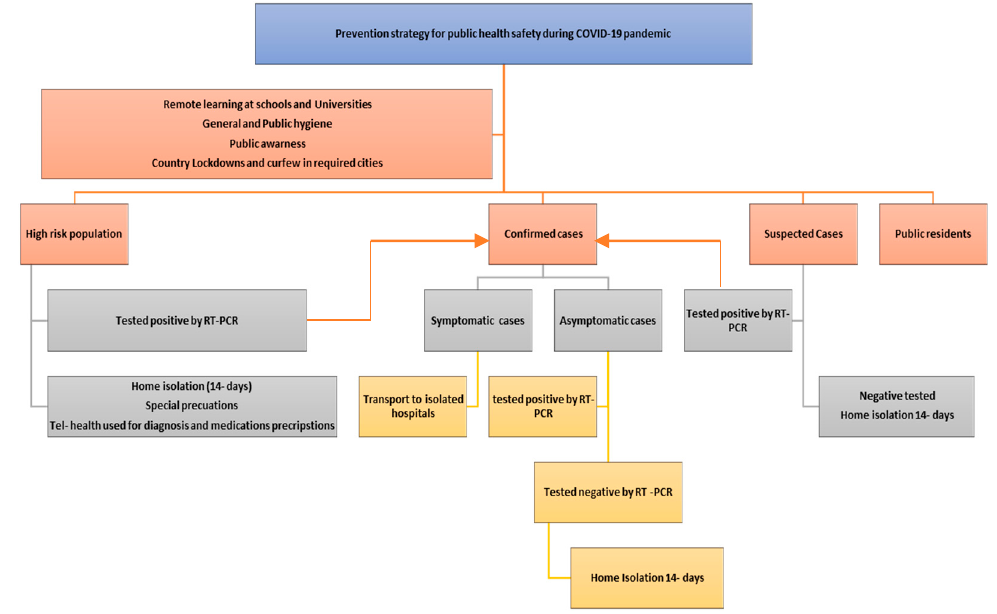
Figure 7. A suggested COVID-19 preventive measures strategy that is valid to the circumstances in Saudi Arabia. Rt-PCR is defined as reverse transcription polymerase chain reaction laboratory test.